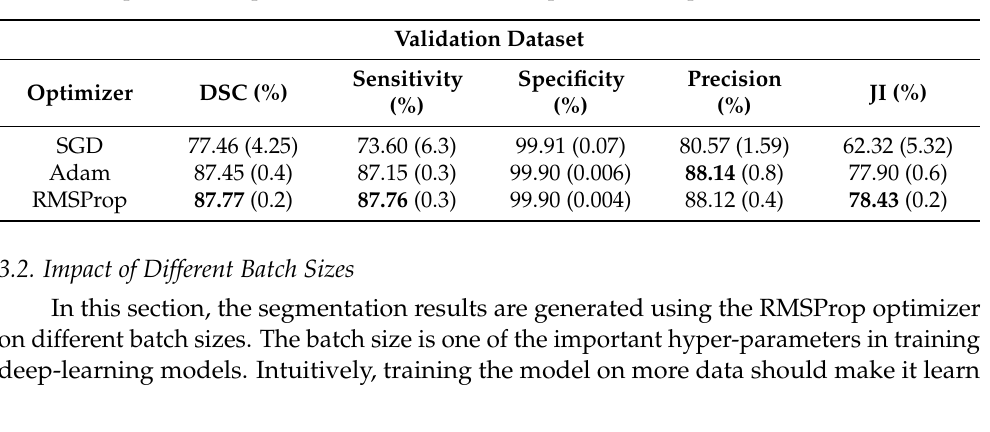
Table 5. Obtained values of five segmentation metrics using the three optimizers: SGD, Adam, and RMSProp. For each optimizer, a batch size of 8 samples and 400 epochs are